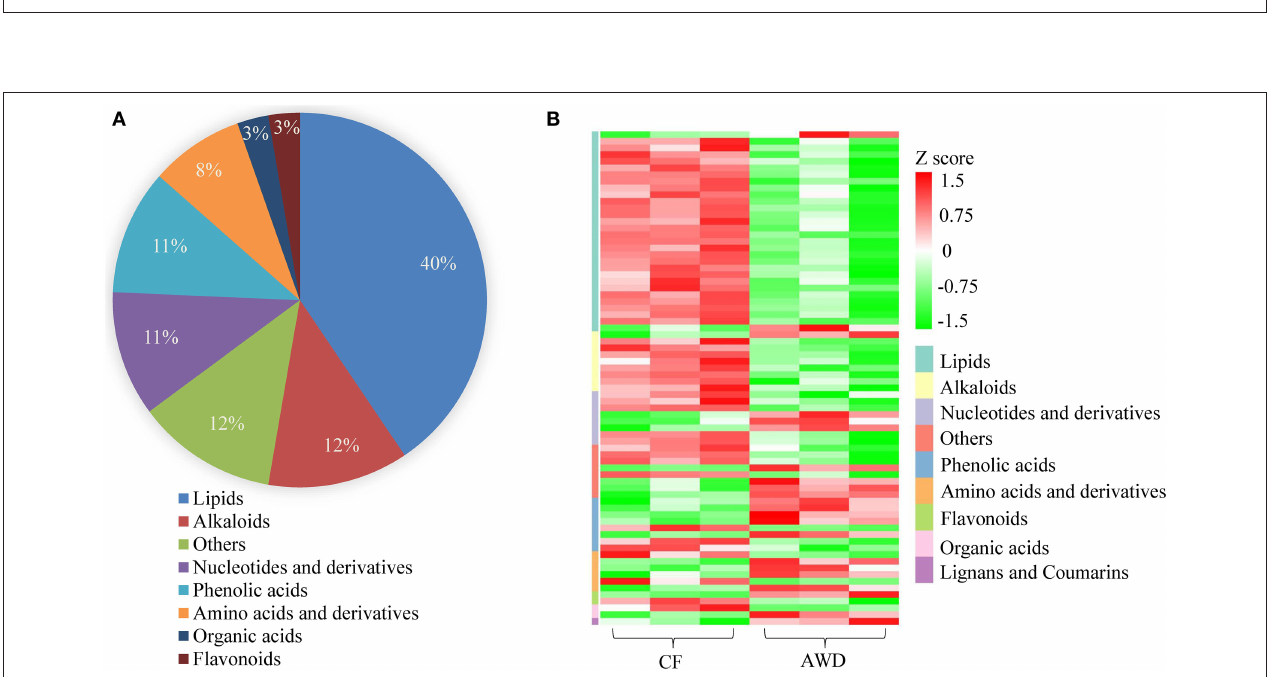
FIGURE 3 | Preliminary characterization of differentially accumulated metabolites in AWD vs. CF. (A) Pie chart depicting the biochemical categories of the differential metabolites identified between CF and AWD samples. (B) Cluster analysis of metabolites from samples of CF and AWD. The color indicates the level of accumulation of each metabolite, from low (green) to high (red). The Z-score represents the deviation from the mean by SD units.